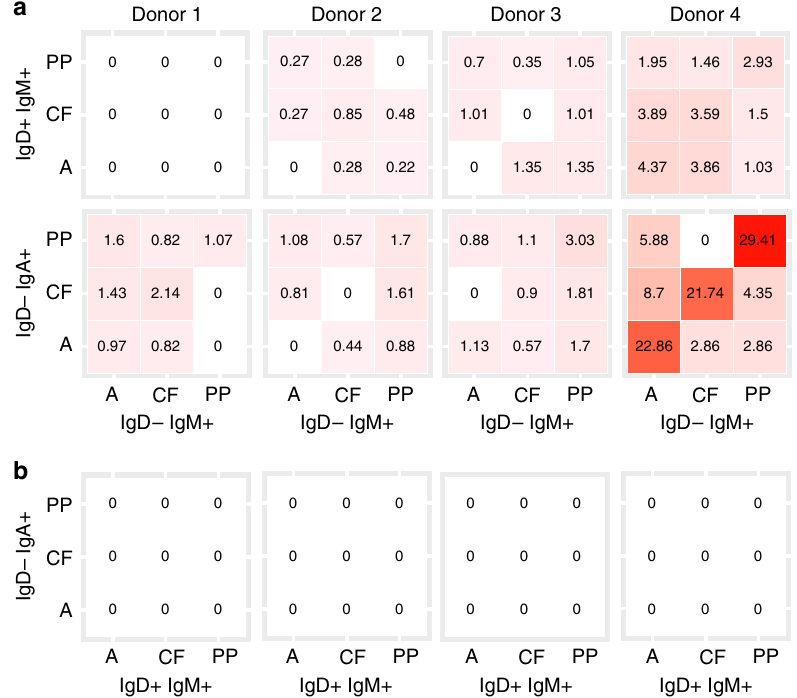
Fig. 8 Analysis of B cells from three different sites from each of four tissue donors. Percentage of sequences with clonal relatives shared between CD27 + IgM + IgD + and CD27 + IgM + IgD − , CD27 + IgA + and CD27 + IgM + IgD − subsets and CD27 + IgA + and CD27 + IgM + IgD + subsets, within and between sites. Numbers in blocks indicate the percentage of shared sequences within or between sites, with darker shading indicating increased